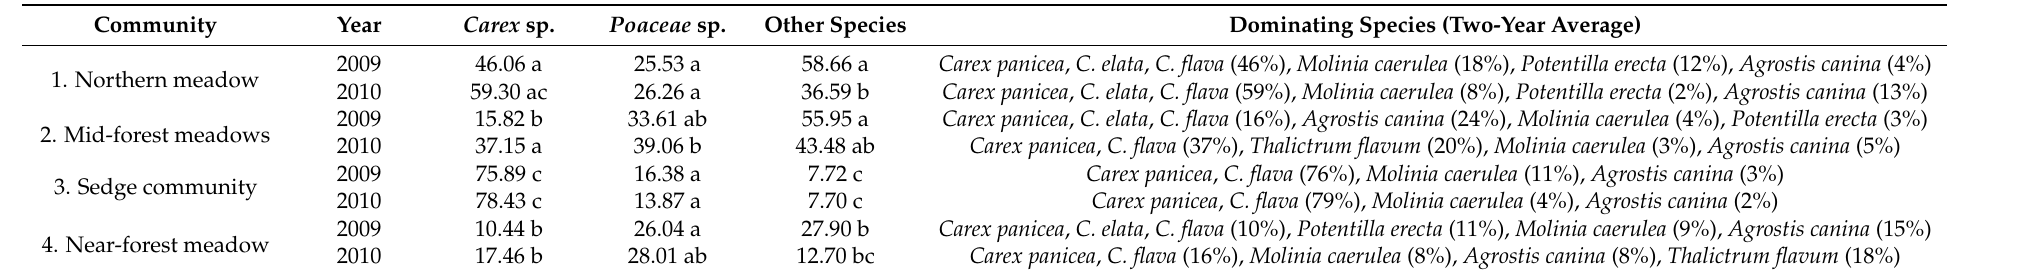
Table 6. The share of particular groups of plant species [% DW] in communities under study in 2009 and 2010.